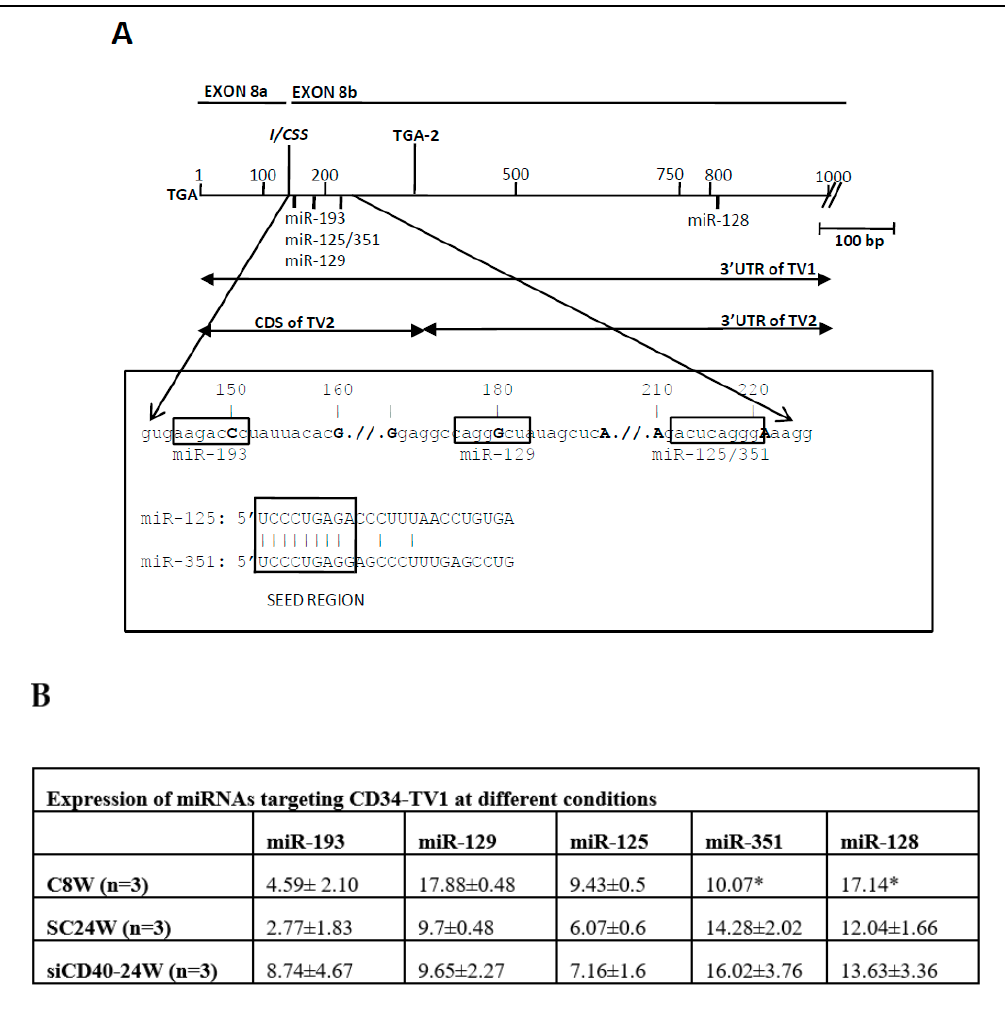
Figure 5. Detailed structure of the Cd34 region harboring the predicted miRNA binding sites.( A ) Diagram of 1 kb of sequence at the 3’end of Cd34 . Shown is the position of the two stop codons (TGA1 and TGA2), the internal/cryptic splice site (I/CSS) and the position of the miRNA binding sites. Expanded is the sequence of the 70 bp, which concentrate the miRNA binding sites. Boxed, the seed sequences of the miRNAs and the comparison among those of miR-125 and miR-351. ( B ) Expression of the miRNAs targeting Cd34 at different experimental conditions. Data shown after normalization to U6-snRNA. Expression data extracted from the original Taqman Low Density Array card (TLDA) experiment [25]. (*) Only one sample could be analyzed.